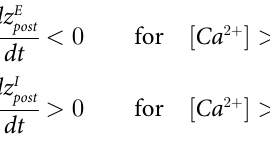
The constraints described by equations Eqs (2), (4) and (5) can be satisfied by families of Gaussian growth rules for excitatory and inhibitory dendritic elements, with � E ¼ c and post Z I ¼ c , respectively (Fig 5A and Table 1). � E and Z I individually represent the stable fixed post post post points for the excitatory and inhibitory post-synaptic growth curves respectively, and their intersection at the neuron’s optimal activity level, ψ , ensures that deviations to the neuron’s activity away from ψ are countered by the turnover of the neuron’s post-synaptic elements. This is further illustrated in the next section. Note that whereas the slope of the growth curve for excitatory post-synaptic neurites is negative at its stable fixed point � E , the slope of the post growth curve for inhibitory post-synaptic elements at Z I is positive because the activity of the post neuron is inversely related to the number of inhibitory post-synaptic inputs it receives.